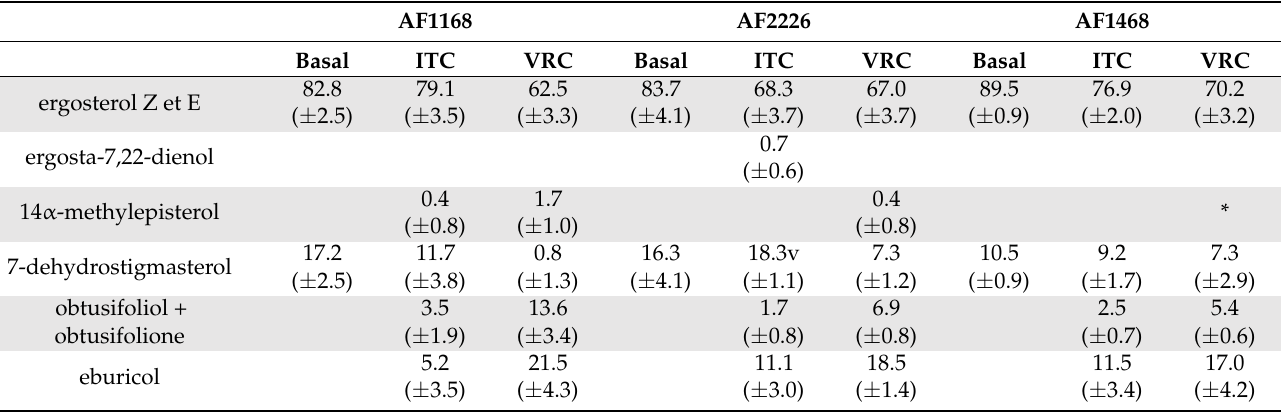
Table 5. Relative composition of sterols of group 3, strains with TR 46 /Y121F/298A alterations, under basal conditions or after in vitro exposure to itraconazole (ITC) (concentration = 0.25 × MIC) or voriconazole (VRC) (concentration = MIC). Values are expressed as the mean of three independent experiments, standard deviation is given in brackets.